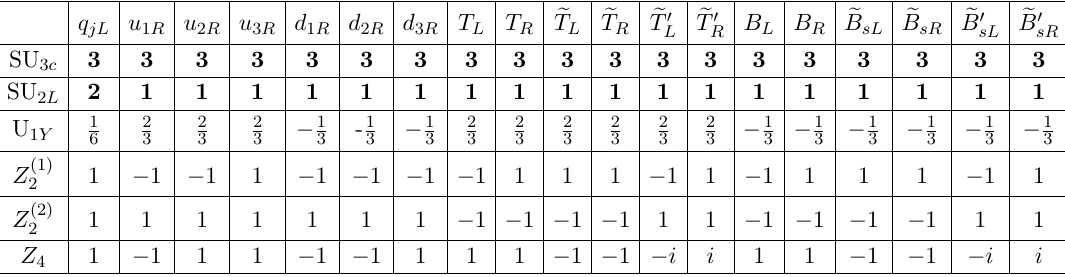
Table 1 . Quark assignments under SU 3 c × SU 2 L × U 1 Y × Z (1) s = 1 , 2